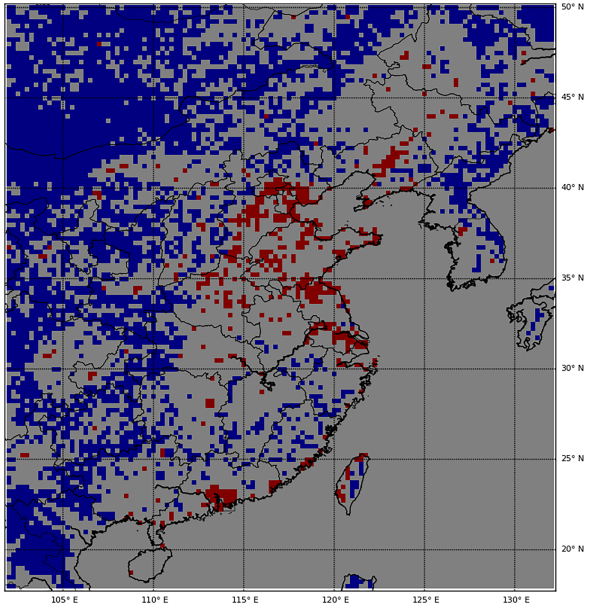
Figure 8. The distribution of urban grid cells (red) and rural grid cells (blue). Urban grid cells have an urban area (as defined in the GCLC database) larger than 5% of the grid cell. Rural grid cells are 100% covered by vegetation (including agricultural land, grass land, shrubs, forest) or barren